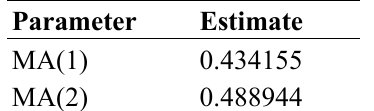
Table 3. Coefficients of ARIMA (0,2,2).